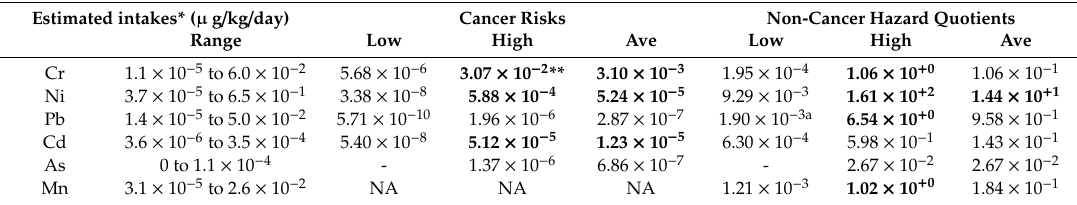
Table 3. Summary of estimated metal intakes, cancer and non-cancer risks from published metal concentration ranges in e-cigarette liquids and / or aerosols using CalEPA RELs, MADLs and cancer slope factors.